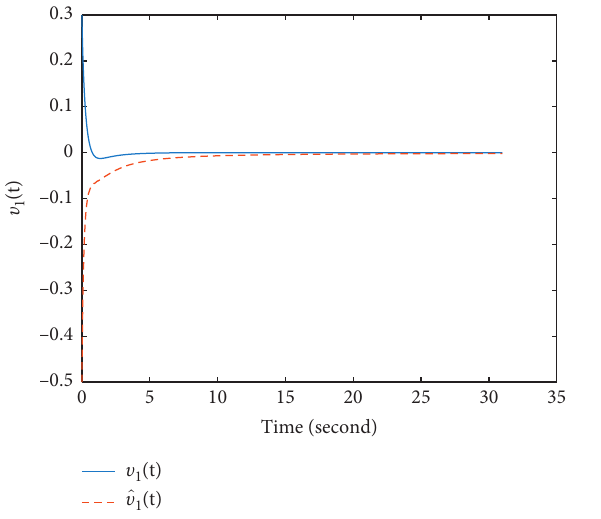
Figure 3: Trajectories of υ